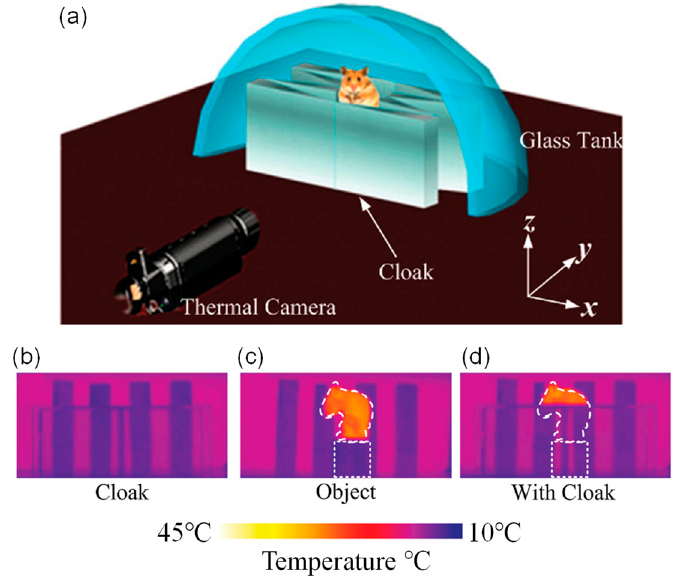
Figure 12. A unidirectional far-infrared cloak for hiding large-scale objects [88]. ( a ) Experimental setup. The thermal images for: ( b ) far-infrared cloak; ( c ) the mouse standing on a cylinder; ( d ) the mouse fixed on a cylinder wrapped by the cloak.